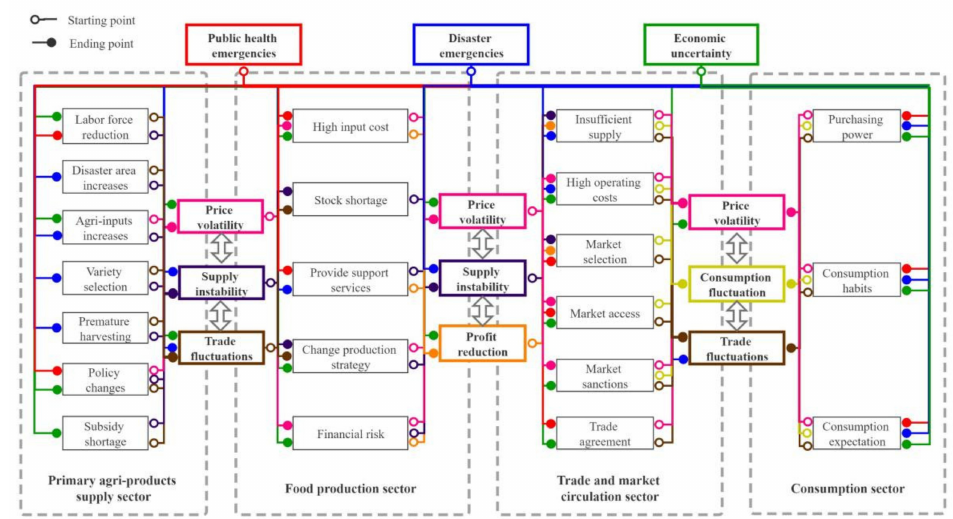
Figure 3. Main impacts caused by external uncertainties in food supply chain. Note: The hollow points in Figure 3 represent the starting points of impacts transmission, and the solid points represent the end points of impacts transmission; the text boxes of different colors represent different impact sources and impact results, and the solid lines of the same color represent the transmission process of the same